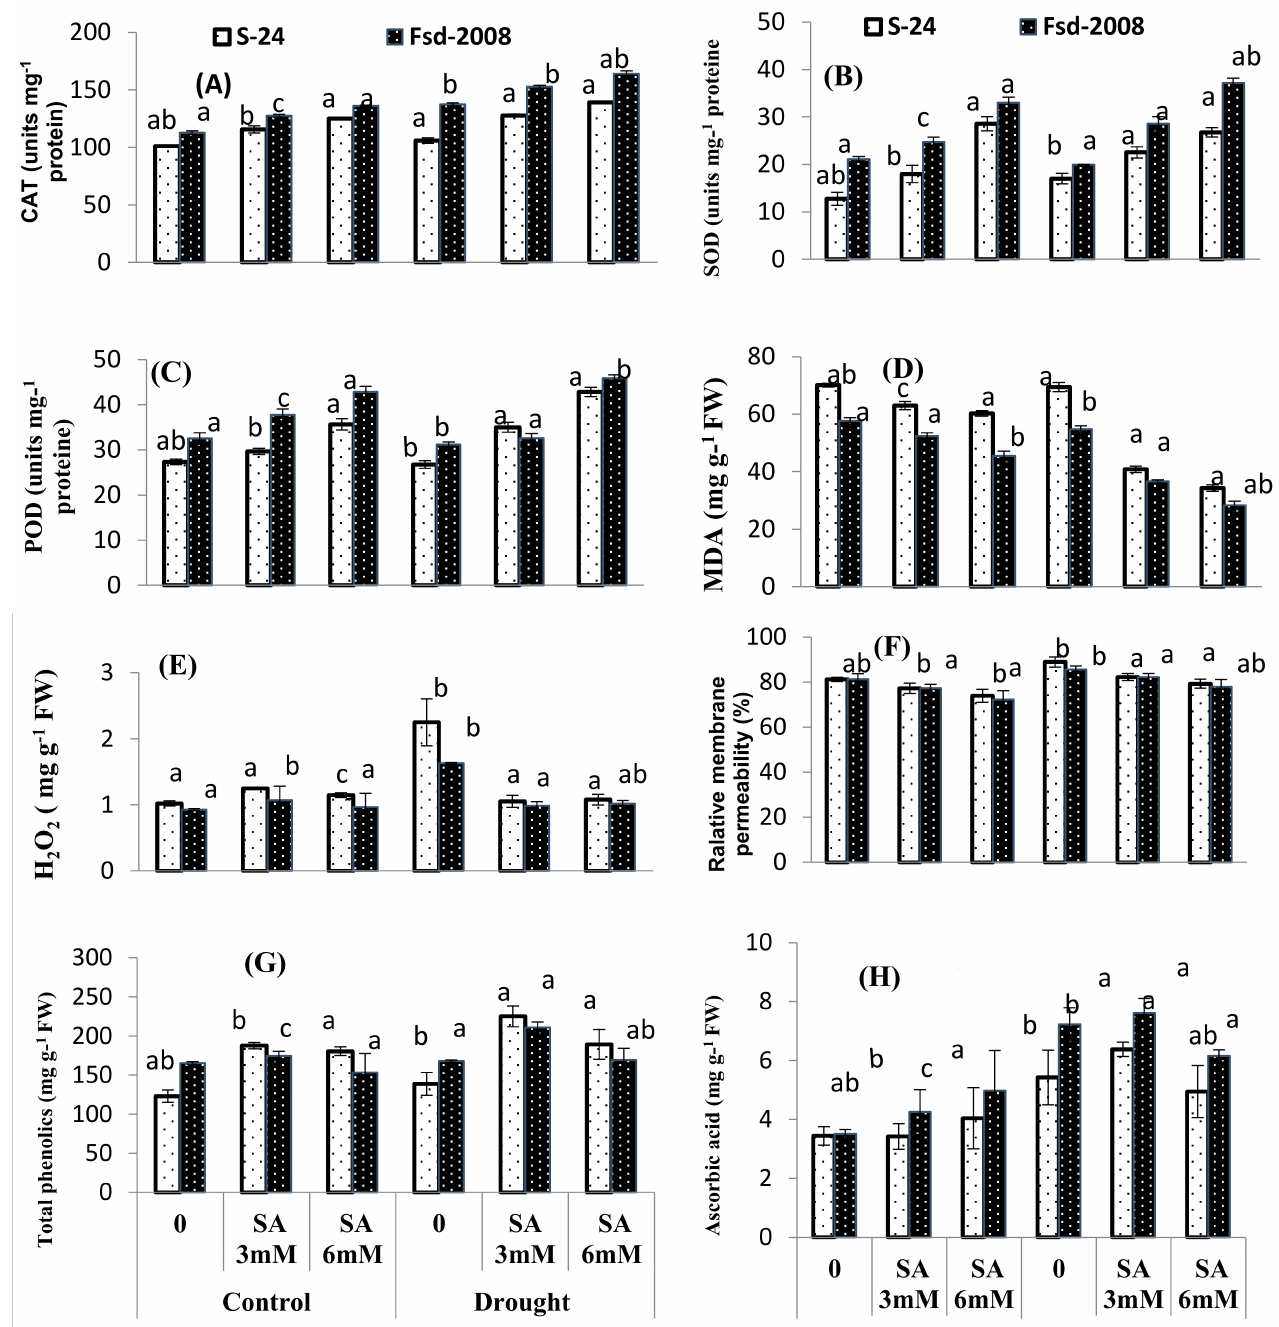
Figure 3. Effect of foliar application of salicylic acid on ( A ) catalase, ( B ) superoxide dismutase, ( C ) peroxidase, ( D ) malondi- aldehyde, ( E ) hydrogen peroxide, ( F ) relative membrane permeability, ( G ) total phenolics, ( H ) ascorbic acid contents, in two wheat cultivars under water-stress conditions. Means with the same letter (S) do not differ significantly at p ≤ 0.05. Error bars above the means indicate standard error ( n =